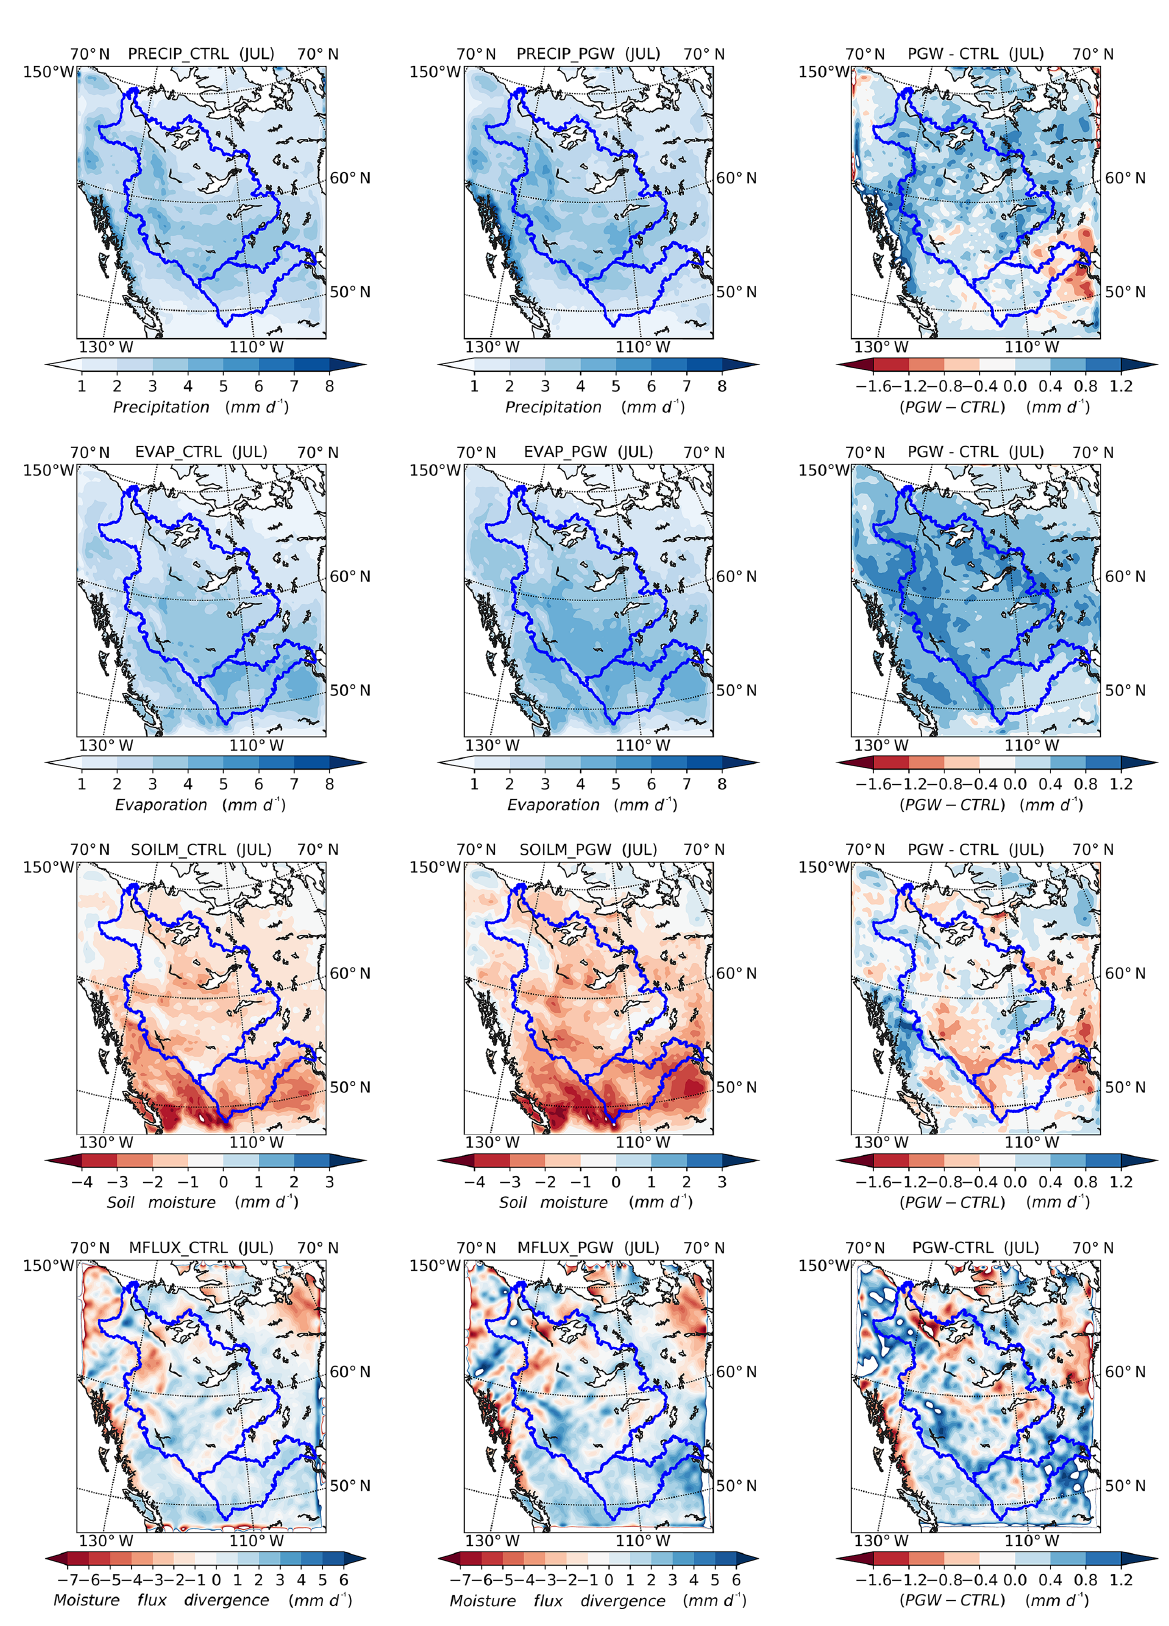
Figure 11. Same as in Fig. 9, except for